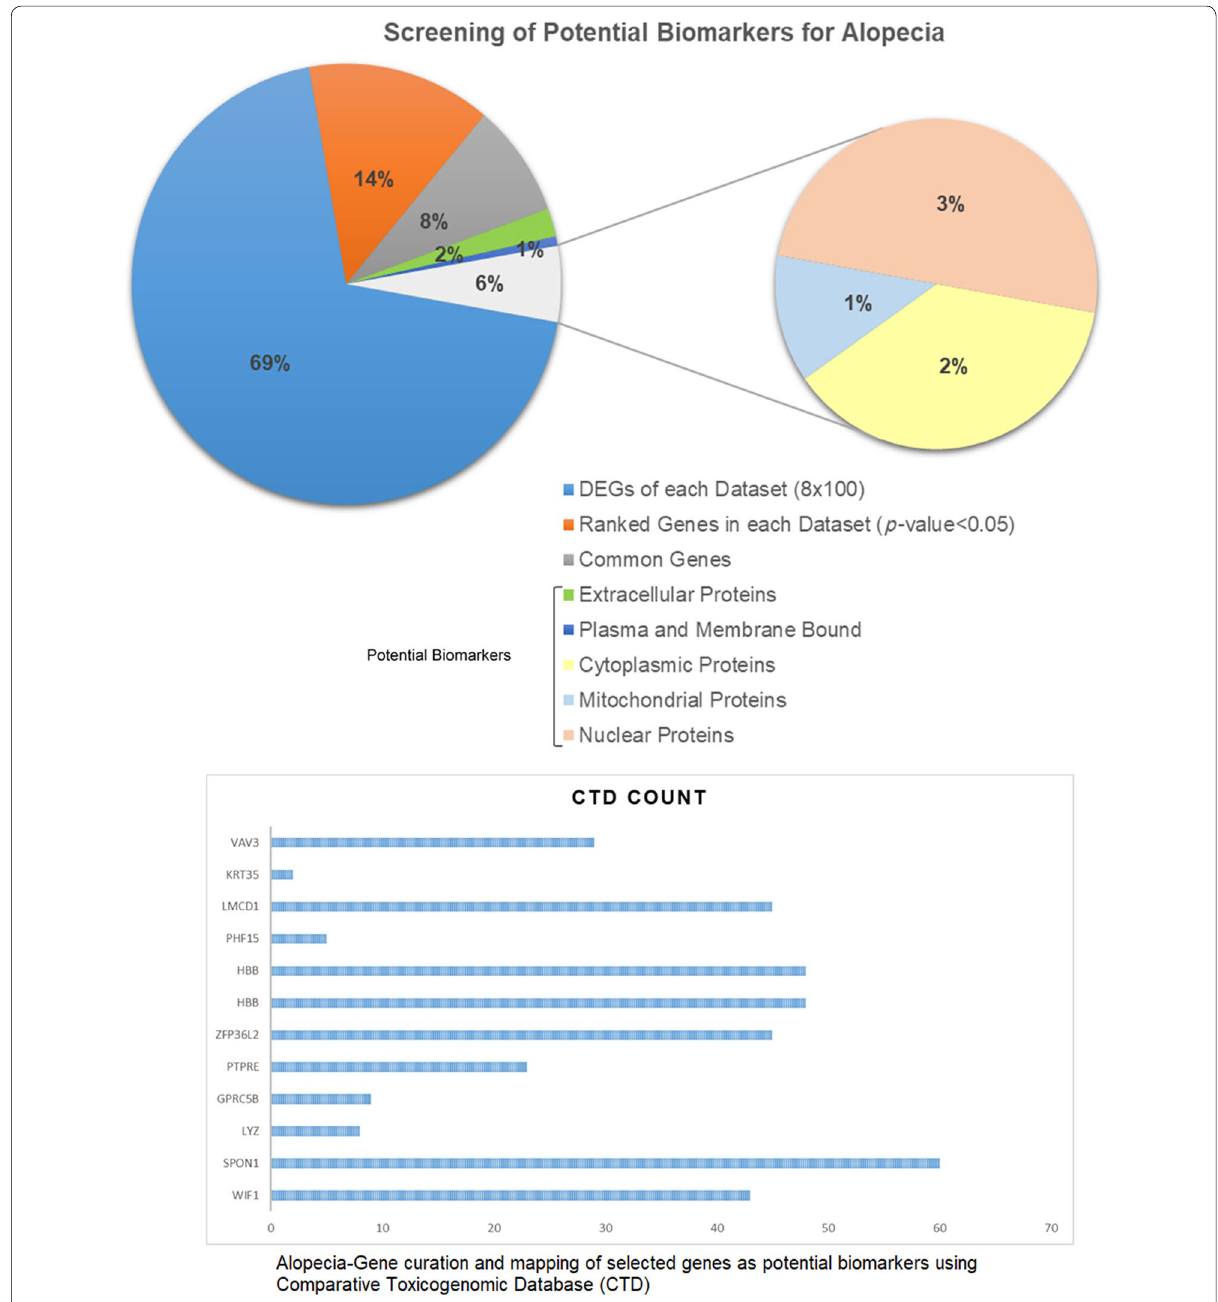
Fig. 3 Screening steps to filter potential biomarkers for alopecia. The bar graph indicates the disease-gene mapping (alopecia-potential genes) using the comparative toxicogenomics database